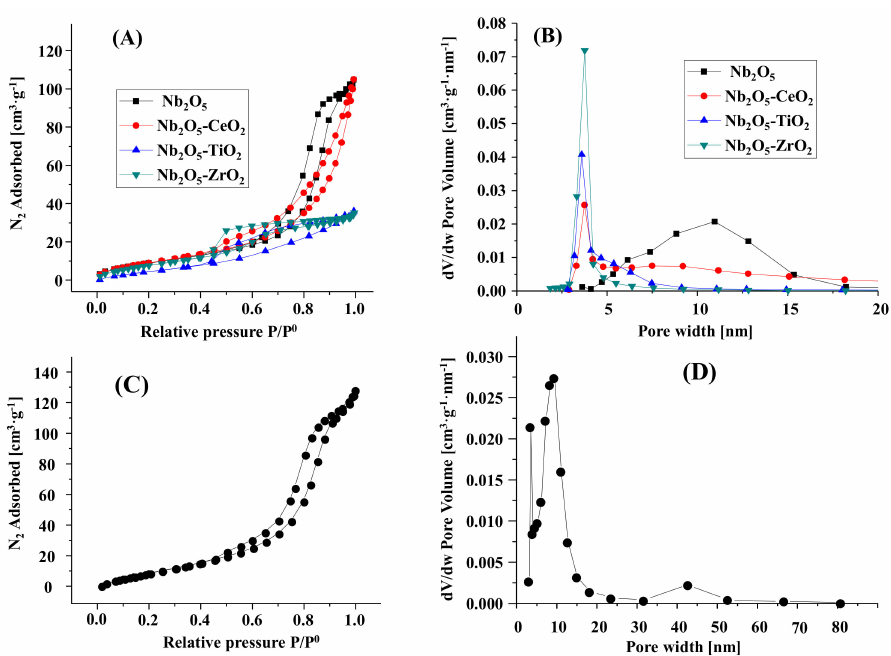
Figure 3. ( A ) N 2 adsorption–desorption isotherms and ( B ) pore size distribution as dV/dw vs. pore width calculated by BJH method on the desorption branch for Nb 2 O 5 and Nb 2 O 5 -based mixed oxides as well as ( C , D ) for the bare TiO 2